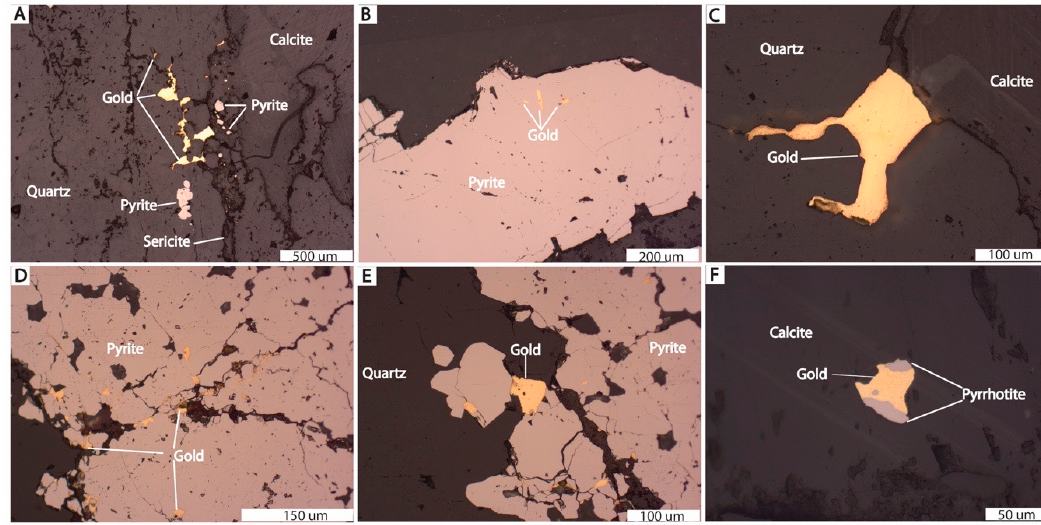
Figure 5. Reflected light microscopy images of gold in quartz veins from Mollehuaca and San Juan de Chorunga, Arequipa-Perú. ( A ) Free gold filling fractures in quartz-calcite microvein; ( B ) Gold microinclusions in pyrite; ( C ) Free gold on the edge of quartz and calcite grains; ( D , E ) Fractures and cavities filled with gold; ( F ) Inclusion of gold in calcite microvein, associated with pyrrhotite.